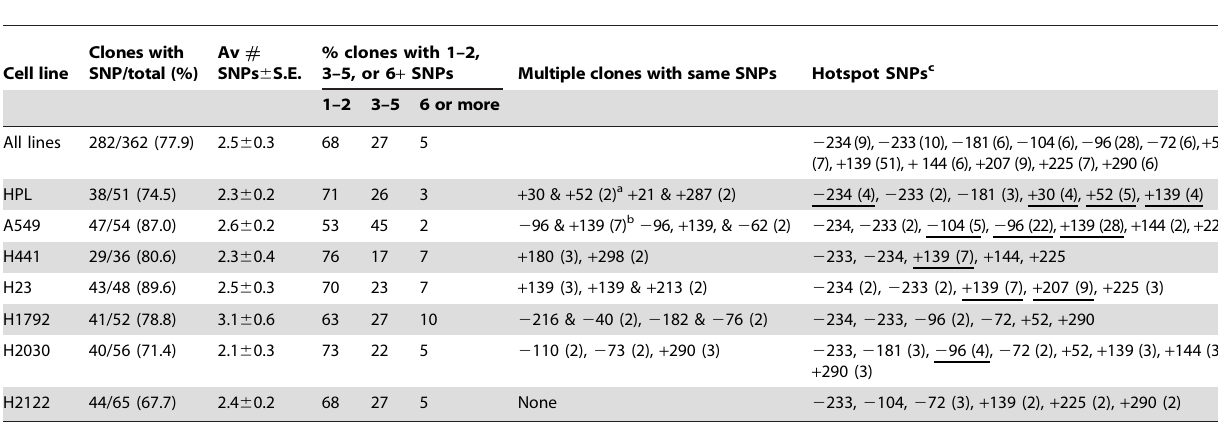
Table 1. rRNA SNPs in HPL non-cancer and 6 lung cancer cell